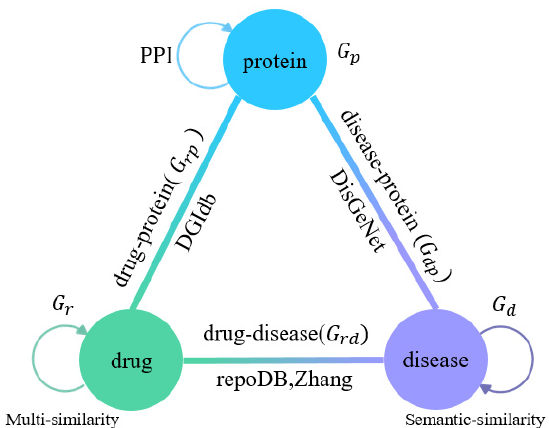
Figure 1. Overall network construction for drug-disease association prediction.